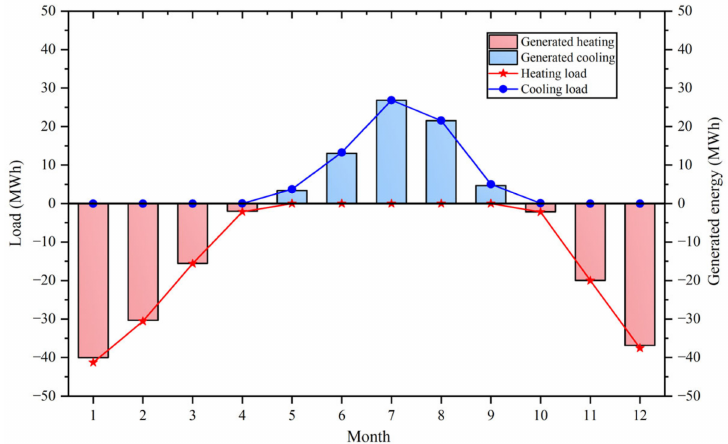
Figure 10. Generated energy and load